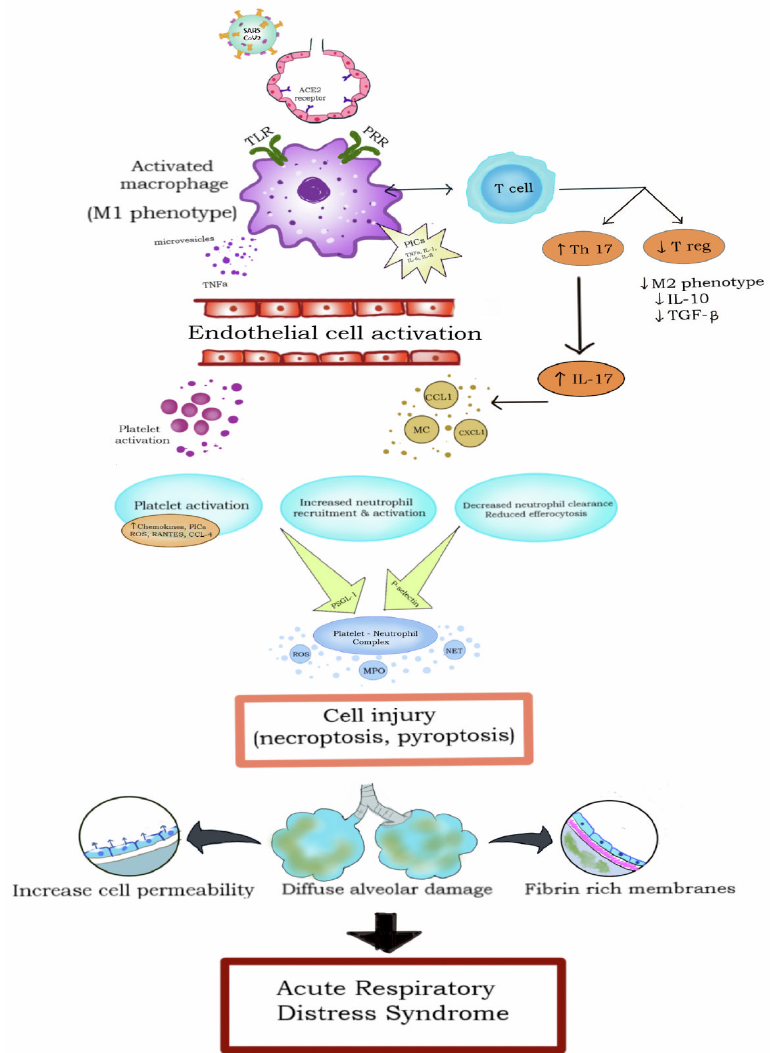
Figure 1. Pathophysiology of acute respiratory distress syndrome in SARS-CoV-2 infection. SARS- CoV-2, severe acute respiratory syndrome coronavirus 2; ACE, angiotensin-converting enzyme; Th, T-helper cell; T-reg, T-regulatory cell; IL, interleukin; TLR, toll-like receptor; PRR, pathogen recognition receptor; PIC, proinflammatory cytokine; TNF, tumor necrosis factor; TGF, transforming growth factor; ROS, reactive oxygen species; RANTES, regulated on activation, normal T cells expressed and secreted; NET, neutrophil extracellular traps; MPO,